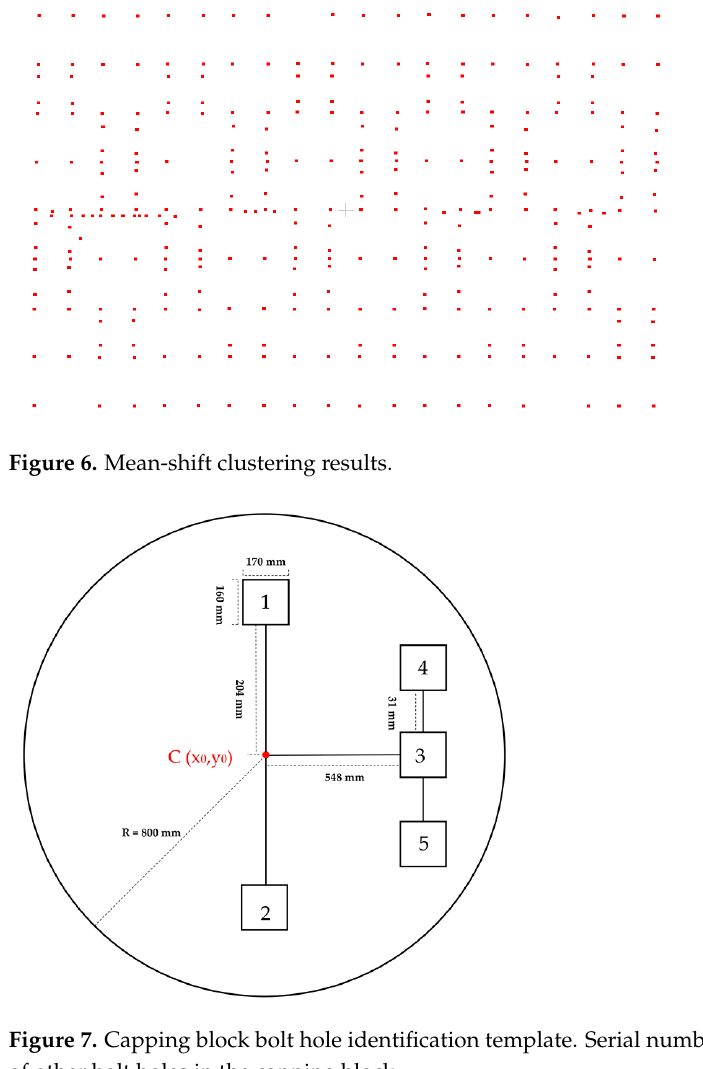
Figure 7. Capping block bolt hole identification template. Serial numbers 1–5 indicate the positions of other bolt holes in the capping block.